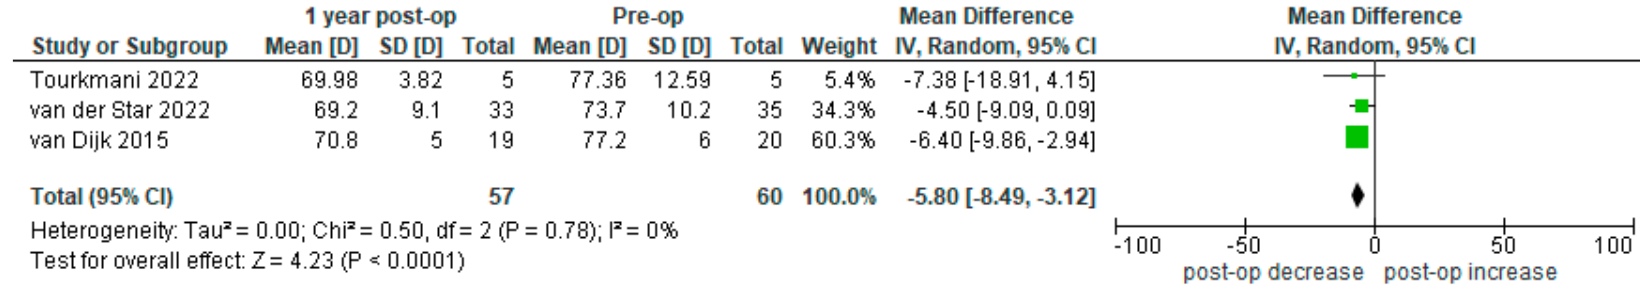
Figure A16. Di ff erence in pachymetry central point across 2 studies [37,43].